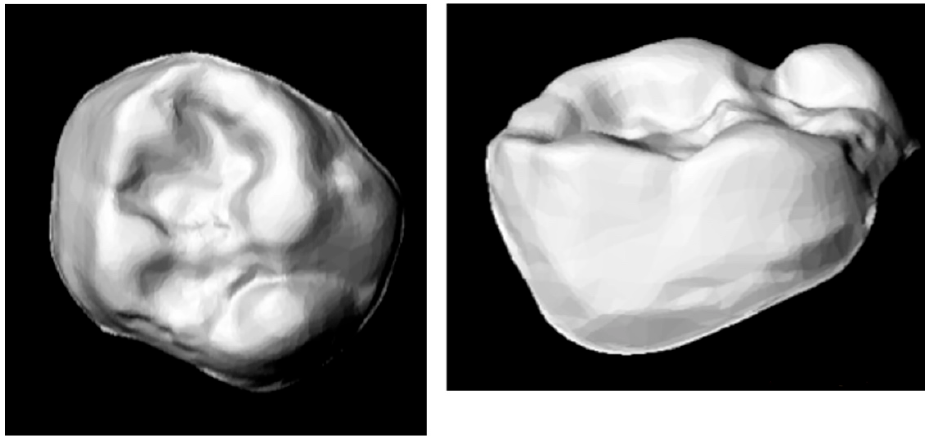
Figure 2. Digital reconstruction of the primary second upper molar.